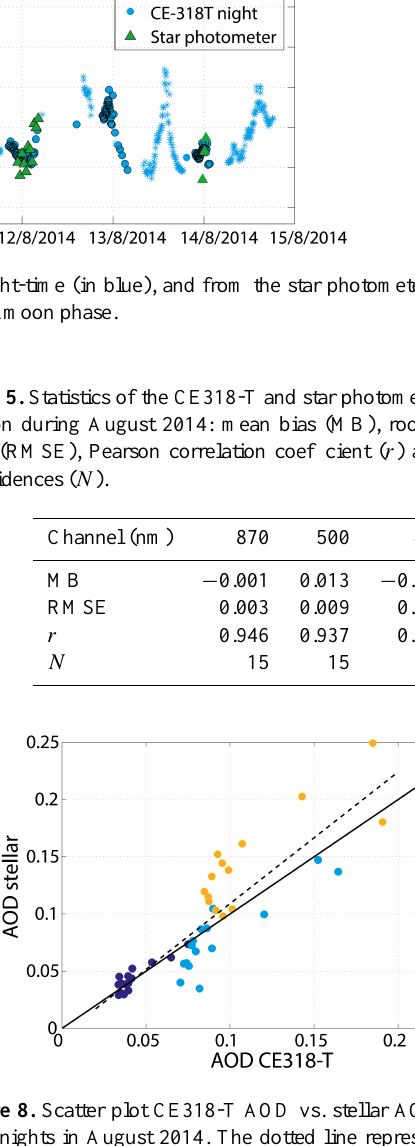
Figure 8. Scatter plot CE318-T AOD vs. stellar AOD at Granada for 4 nights in August 2014. The dotted line represents the linear regression line, and the solid line is the 1 : 1